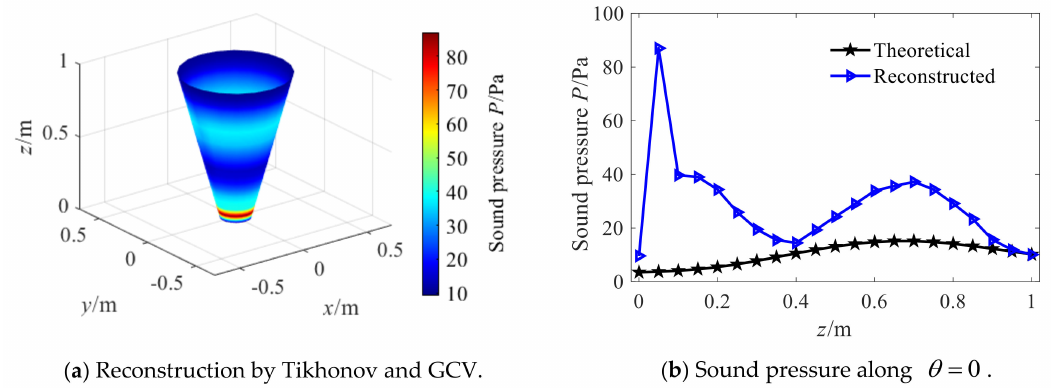
Figure 17. Reconstruction by Tikhonov and GCV.